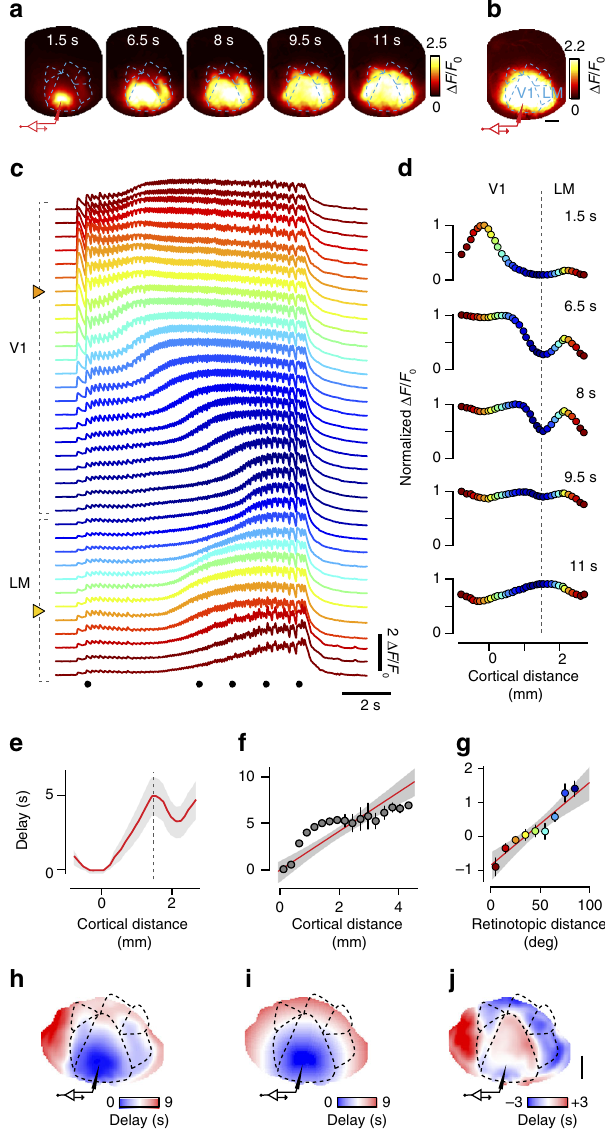
Fig. 5 Seizure propagation recruits homotopic regions of cortex. a Frames imaged in a representative seizure. Labels indicate time from seizure onset, and cartoon electrode indicates the site of Ptx injection and LFP recording. b Maximum extent of seizure invasion averaged across 14 seizures in this mouse. c Single-trial time course along the ROIs in Fig. 4b, for the seizure in a . Dots mark the representative times in a and d . Arrowheads mark the focus in V1 and homotopic region in LM. d Spatial pro fi le of the seizure in c , at representative times, normalized to their maximum. e Seizure invasion delay averaged across seizures. Shaded area represents s.e.m. f Same, averaged across four animals. Error bars indicate two s.e.m. Line: linear fi t, with shaded 95% con fi dence interval. g The residuals of the linear fi t in f reveal a clear dependence on retinotopic distance from the focus. Line: linear fi t, with shaded 95% con fi dence interval. h Map of delay to seizure invasion, averaged across 14 seizures in one mouse. i Prediction of that map based solely on cortical distance from the focus. j Residuals of that prediction. Scale bars are 1